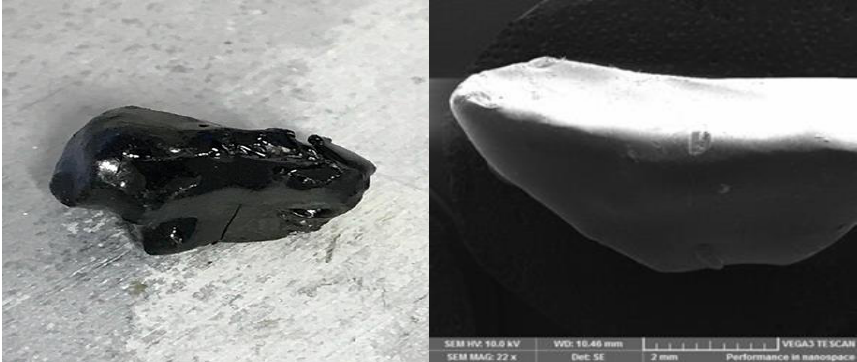
Figure 15. A piece of aggregate coated with base binder.